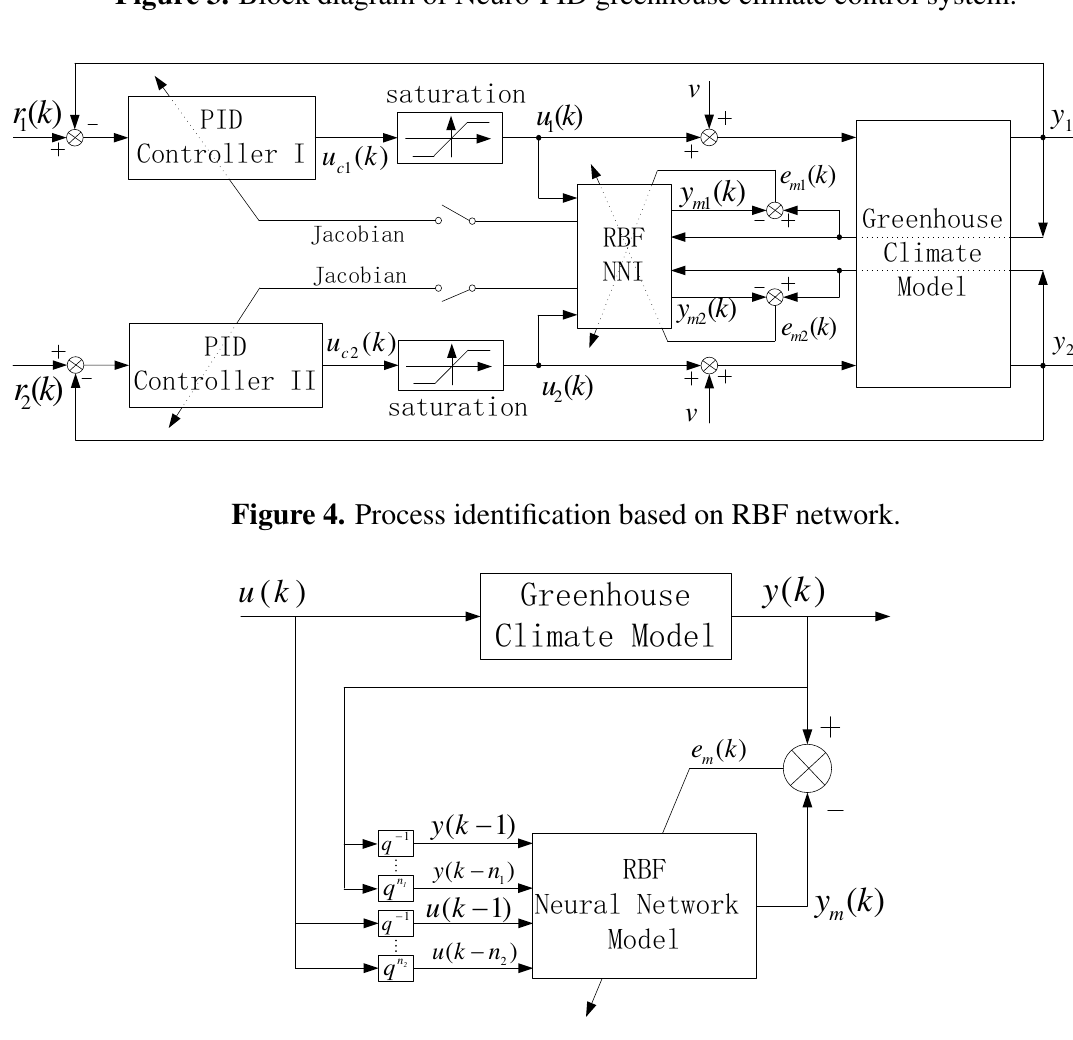
Figure 3. Block diagram of Neuro-PID greenhouse climate control system.